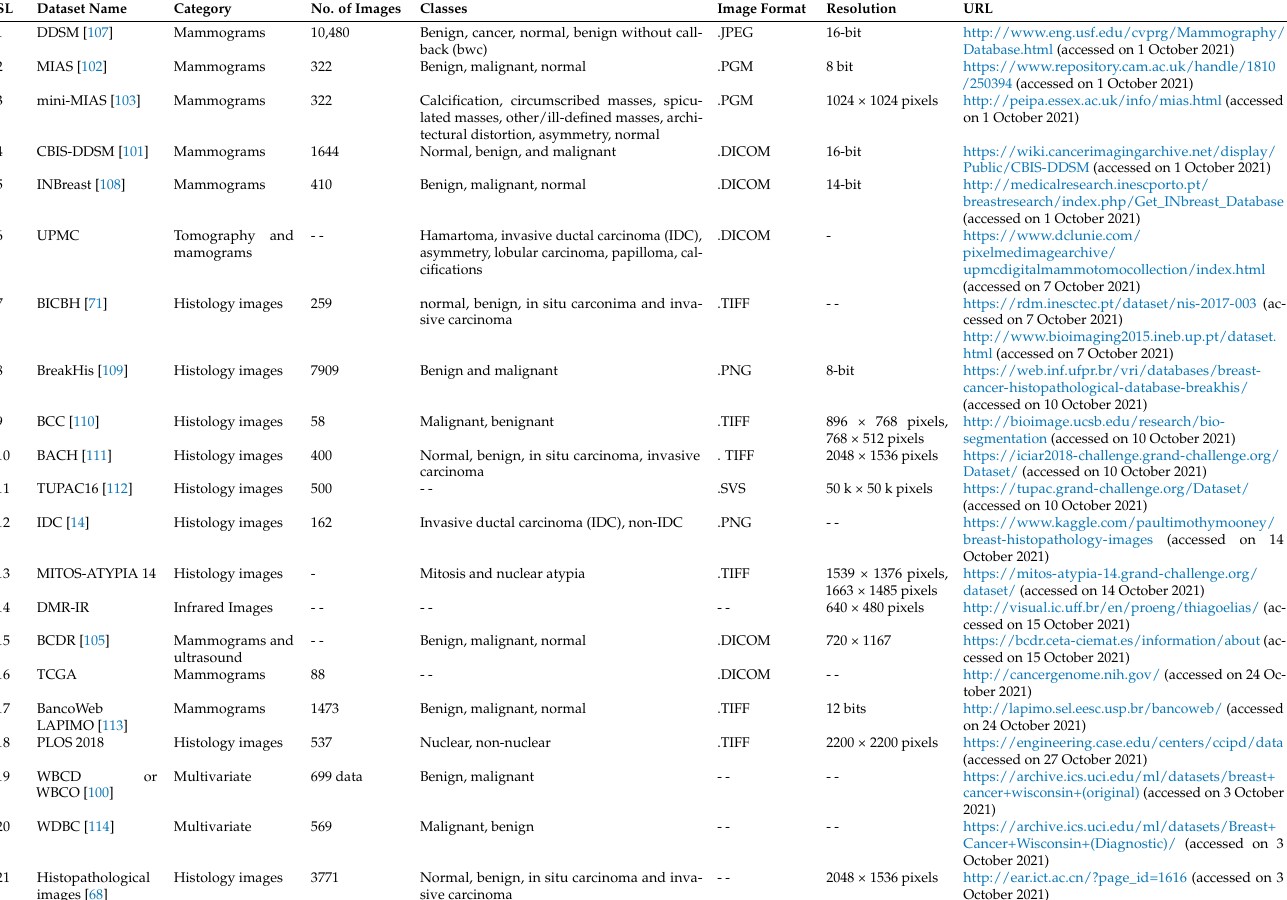
Table 10. Detailed information of publicly available